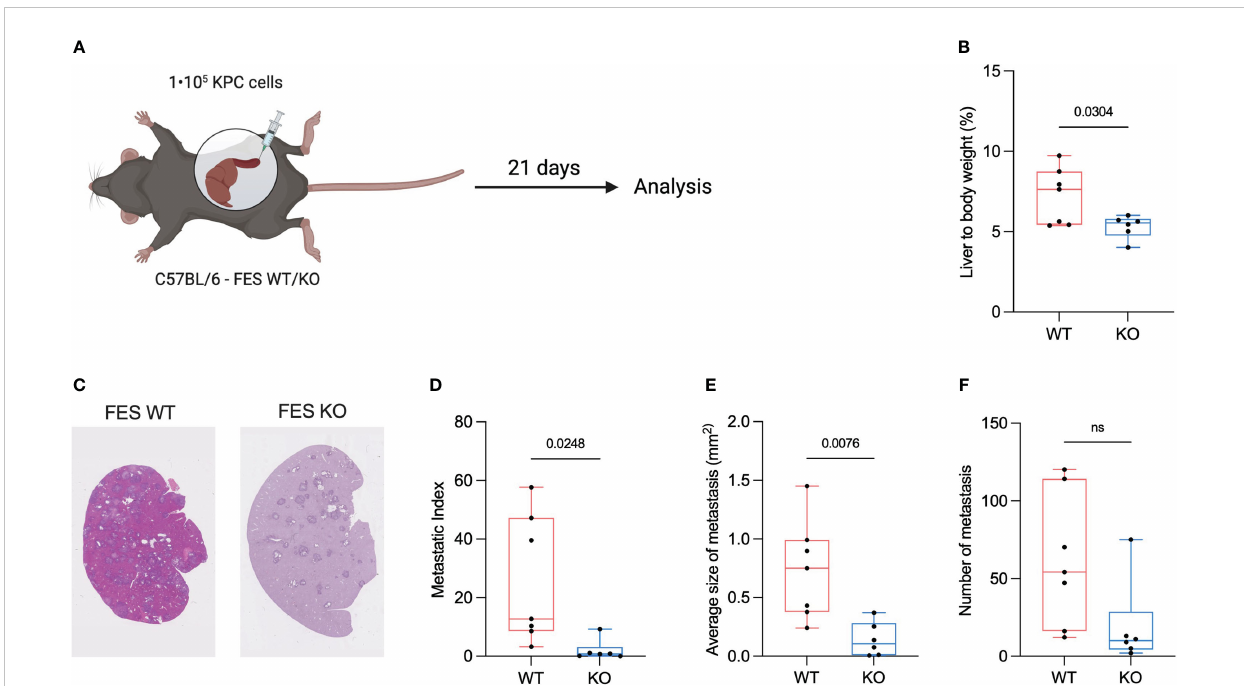
FIGURE 2 FES null mice attenuate progression of hepatic PDAC metastasis. (A) , Schematic showing intrasplenic implantation of KPC mT4 cancer cells. (B) , Liver weight (%) of total body weight WT and FES null mice with metastatic disease. (WT mice n=7, FES null mice n=6). (C) , Representative hematoxylin & eosin stainings from FES WT and FES KO mice (D) , Metastatic index calculated as a percentage of metastatic lesions from hematoxylin and eosin stained liver section in WT and FES null mice. (WT mice n=7, FES null mice n=6). (E) , Quanti fi cation of average size of metastatic lesions from hematoxylin and eosin stainings (WT mice n=7, FES null mice n=6). (F) , Number of metastatic lesions per liver after intrasplenic injection (WT mice n=7, FES null mice n=6). Data in c – f are from two independent experiments. Bar graphs represent mean and standard deviation; hypothesis testing was performed using unpaired two-sided Student ’ s t test. ns, Non signi fi